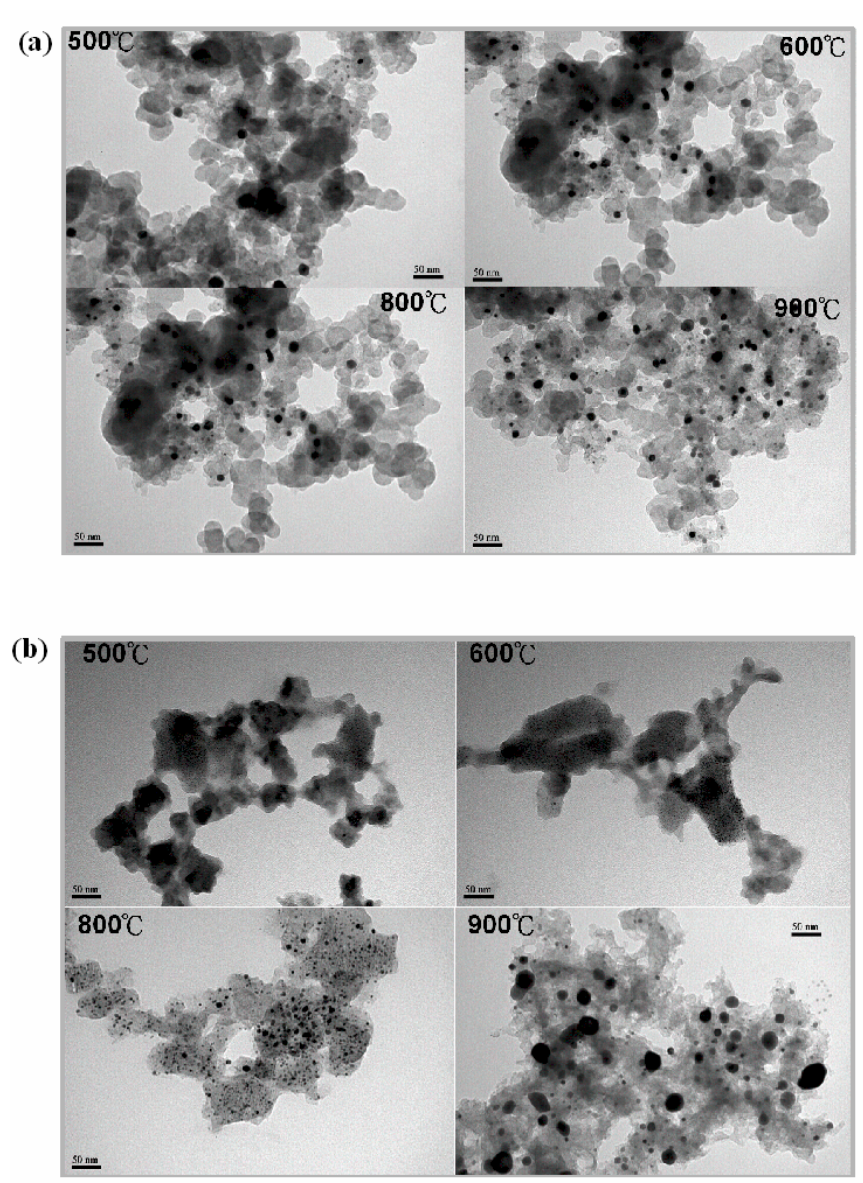
Figure 2. TEM images of various Pt-catalysts treated at different temperatures: ( a ) Pt/XC72 and ( b ) Pt/EB-XC72.